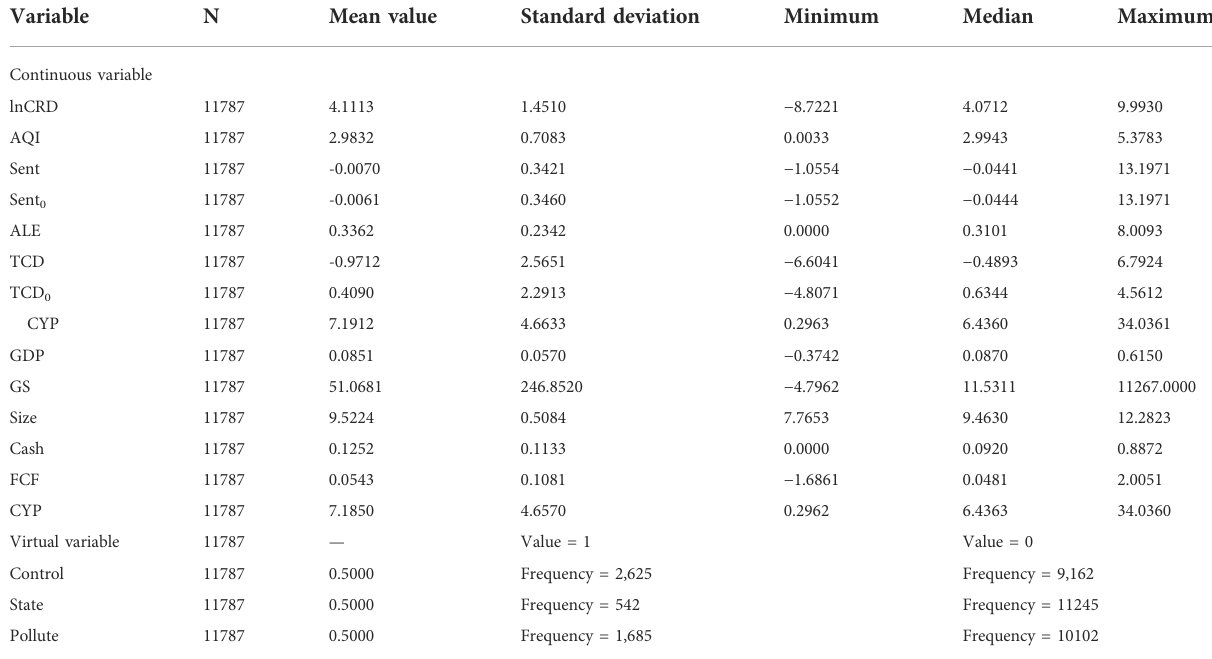
TABLE 2 Descriptive statistical analysis of